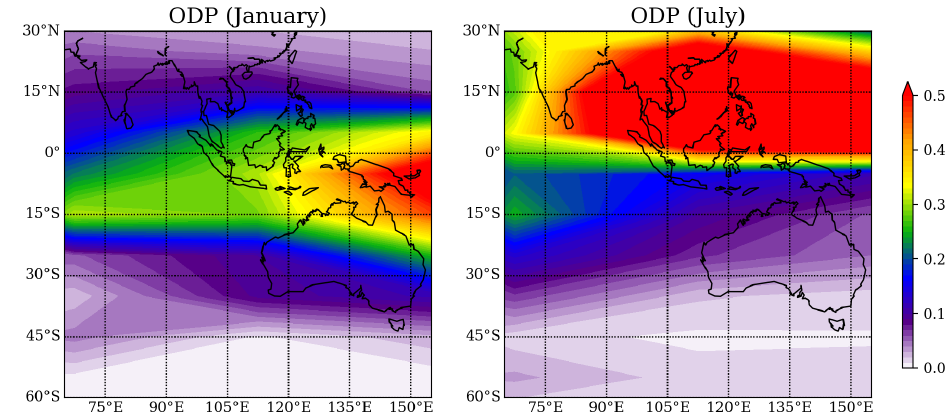
Figure 7. Spatial distribution of the ODP in January and July from Pisso et al. (2010), plotted with interval of 0.01.